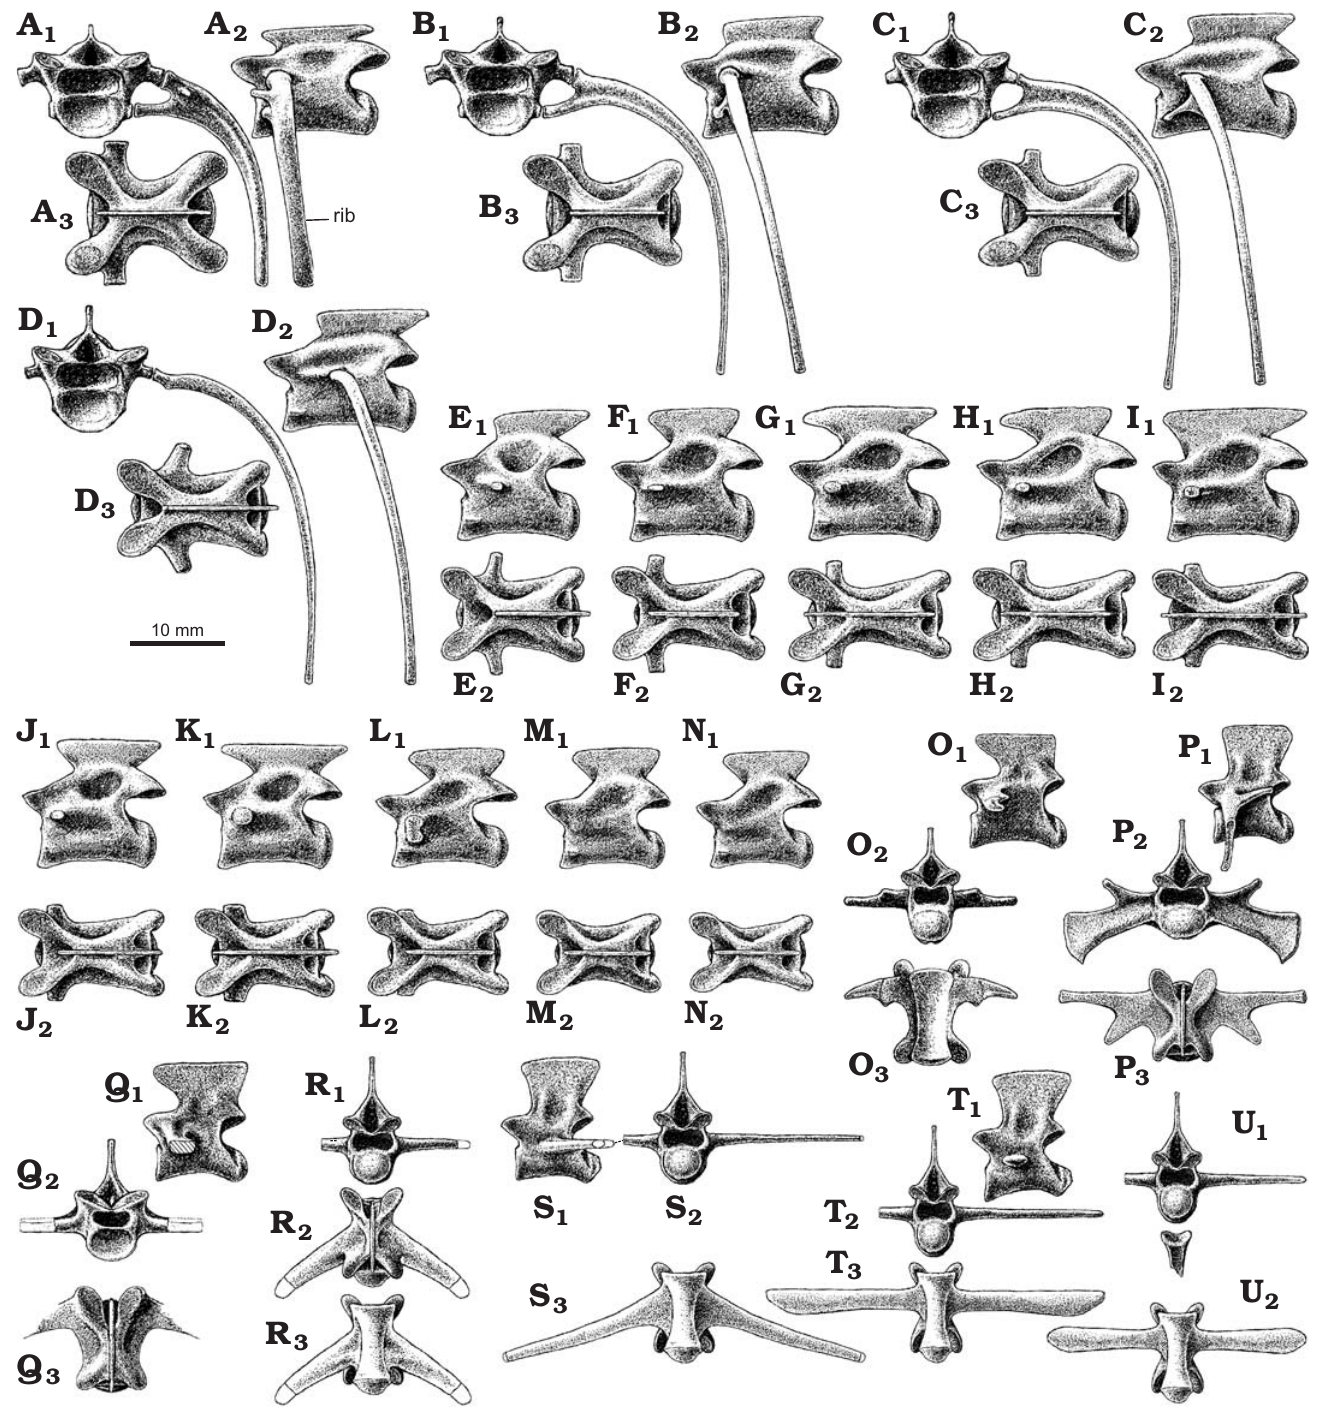
Fig. 10. Restoration of postcervical vertebrae of long-necked reptile Ozimek volans gen. et sp. nov. Dorsal 1 with ribs ( A ), dorsals 2–16 ( B – N ), based on ZPAL AbIII/2511, /2512, /3191. Sacrals 1–3 ( O – Q ), based on ZPAL AbIII/2511. Caudals 1, 2, 4 ( R – T ), caudal 6 with chevron ( U ), based on ZPAL AbIII/2512. In anterior (A 1 –D 1, P 2, Q 2 ), left lateral (A 2 –D 2 , E 1 –T 1 ), and dorsal (A 3 –D 3 , E 2 –N 2 , P 3 –R 3 ), posterior (O 2 , P 2 , R 2 , S 2 , T 2 , U 1 ), and ventral (O 3 , R 4 , S 3 , T 3 , U 2 )